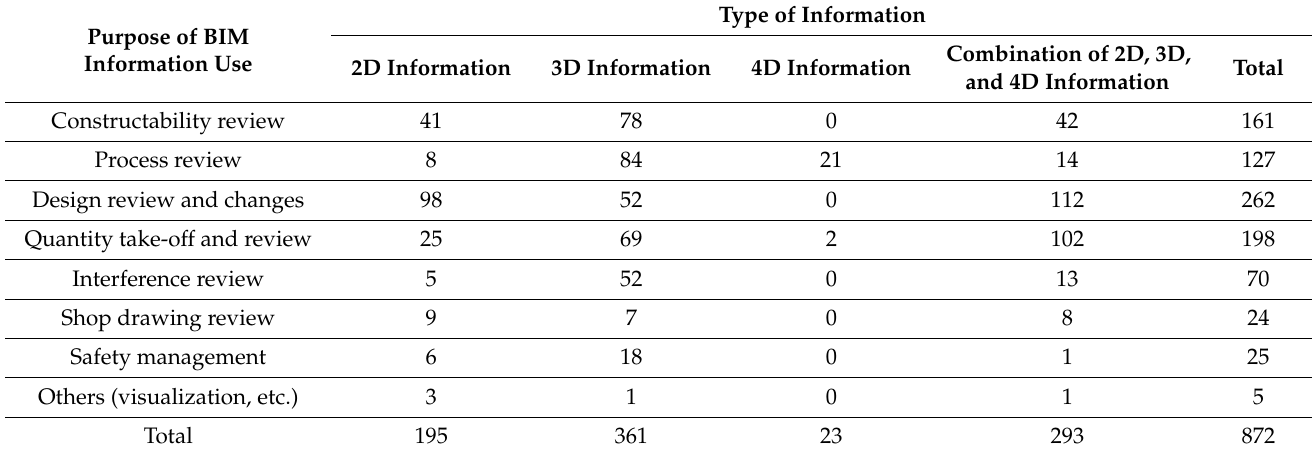
Table 3. Classification of information types for the BIM RFIs by purpose of information use.